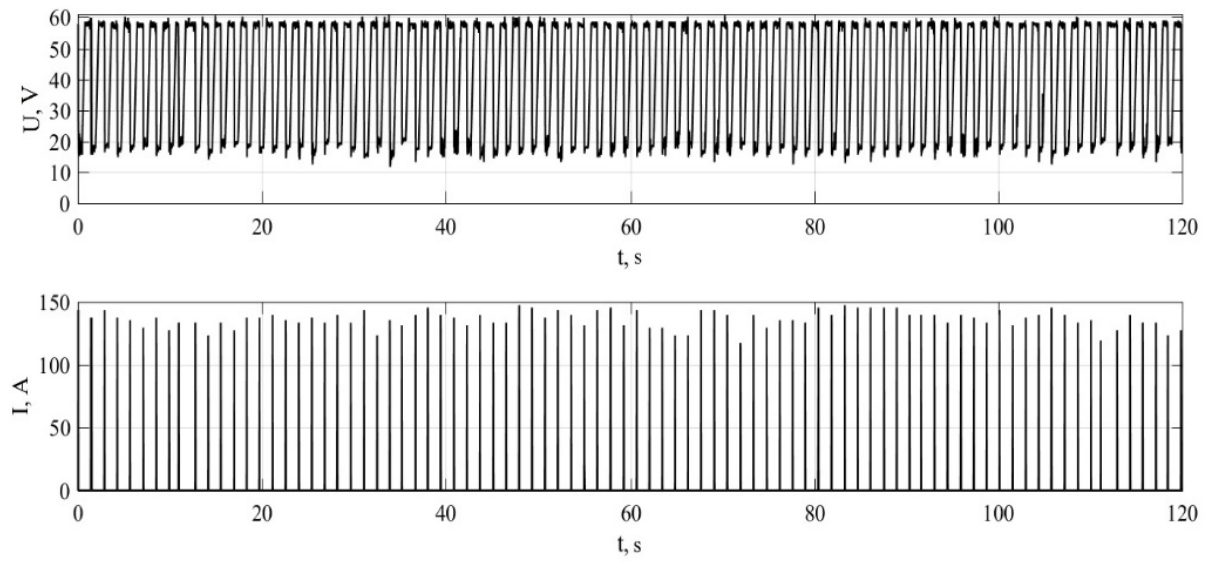
Figure 2. Oscillogram of pulses at a voltage of 60 V and capacitance of capacitor of 41 mF.